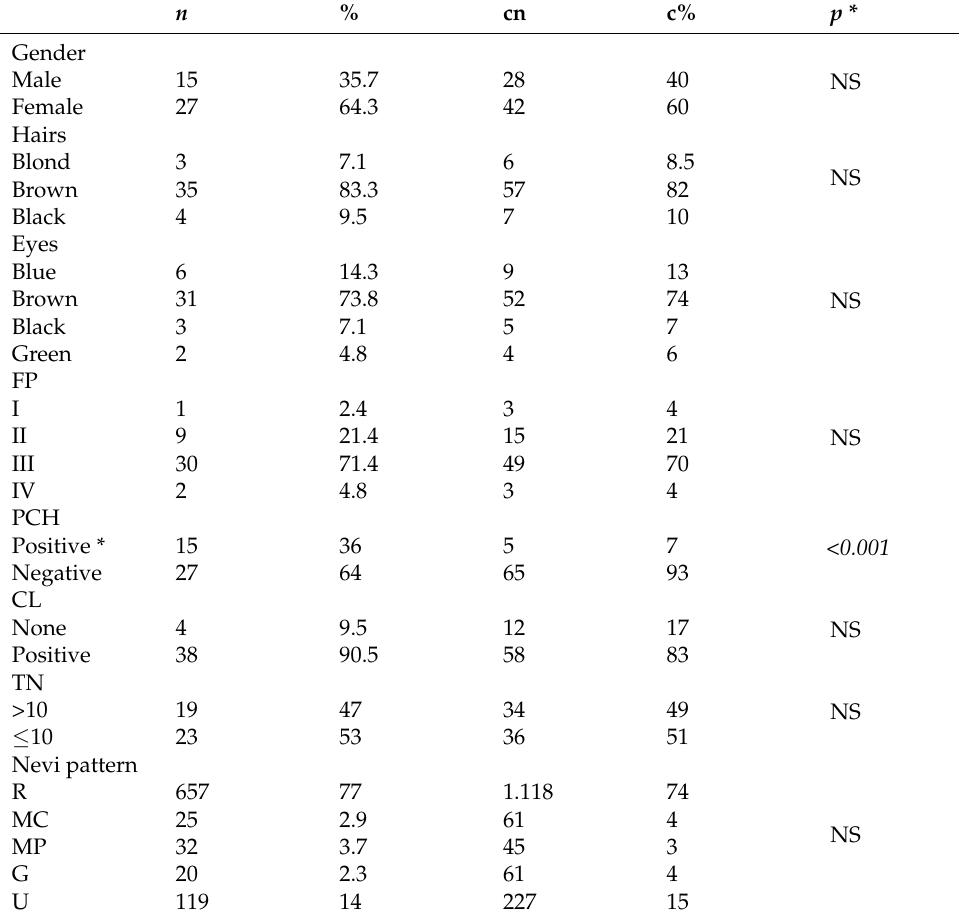
Table 1. Clinicopathologic features of the